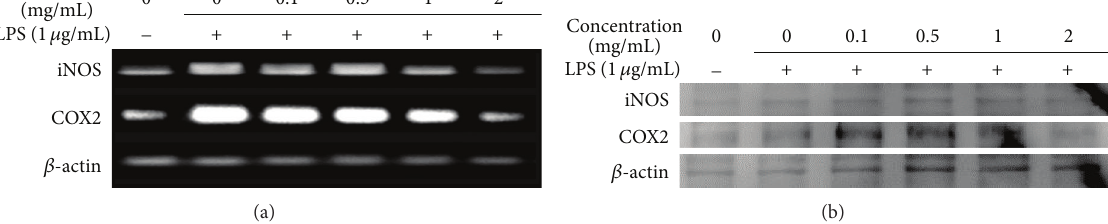
Figure 3: Effect of AM on the iNOS and COX-2 gene expressions (a) and protein levels (b) in LPS-stimulated RAW 264.7 cells shown by RT-PCR and Western blotting, respectively. The cells were treated with various concentrations of AM for 1h prior to the addition of LPS and the cells were further incubated for 24 h.